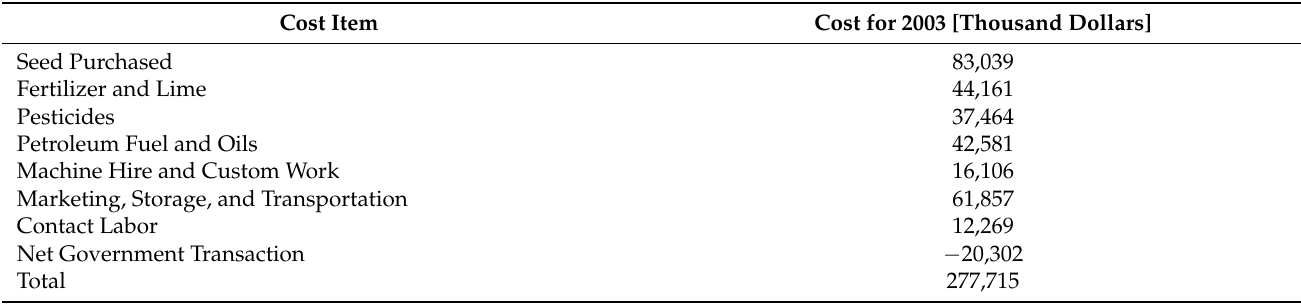
Table A1. Itemized cost estimates for farm operations. These values represent the average seasonal price received by Maryland farmers in 2003, as reported by the Maryland Agricultural Statistics Services (MASS).